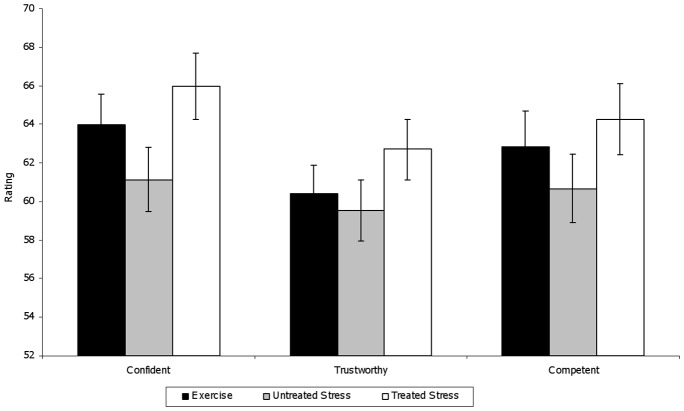
Mean and standard errors of the confidence, trustworthiness and competence ratings of the women depicted in the videos as a function of the sweat odor pairing condition.